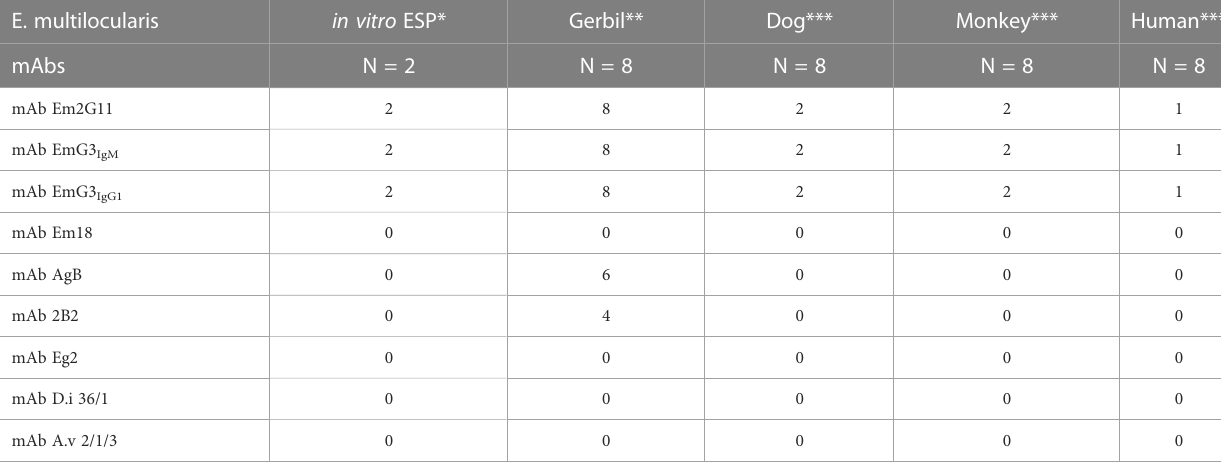
TABLE 4 Antigen binding of mAbs with extravesicular in vitro ESPs and circulating serum antigens of E. multilocularis metacestode infections by sandwich-ELISA. E. multilocularis in vitro ESP*